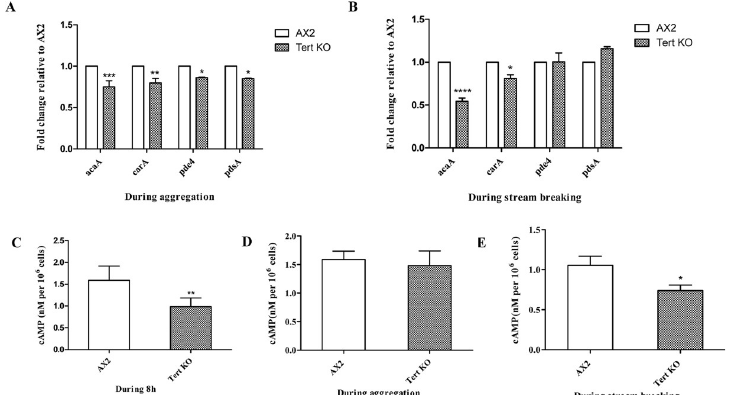
Fig 10. Defective cAMP relay of tert KO. cAMP relay and expression of acaA , carA , pde4 , pdsA in tert KO during (A) aggregation and (B) stream breaking. Fold change in mRNA expression is relative to AX2 at the indicated time points. rnlA was used as an mRNA amplification control, (n = 3). cAMP levels in tert KO during (C) 8 h of development in AX2 and tert KO, (D) aggregation, (E) stream breaking. Level of significance is indicated as � p < 0.05, �� p < 0.01, ��� p < 0.001, and ���� p < 0.0001; (n = 3).